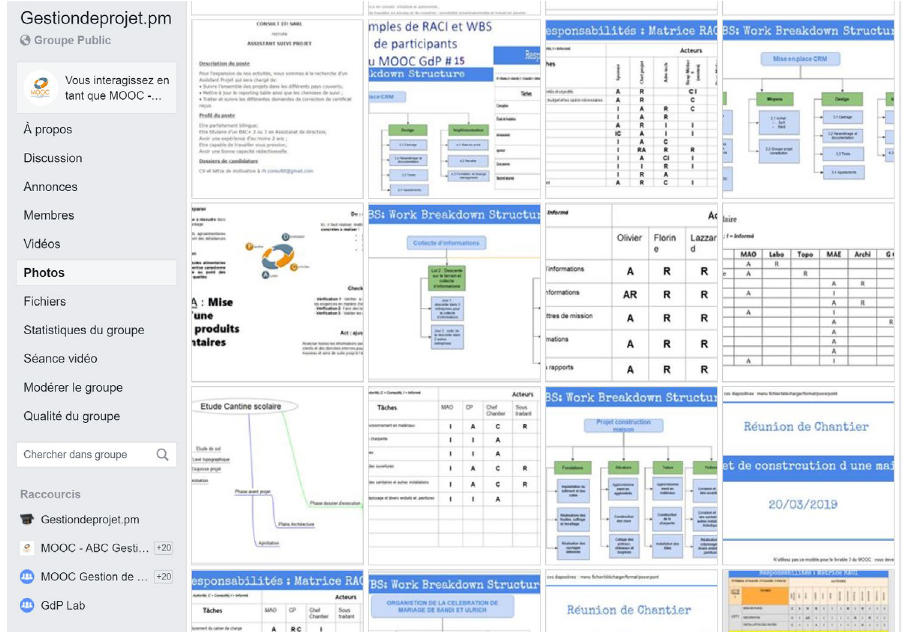
Figure 8. Contextualizing learning: Screenshot of the Facebook deliverable-sharing